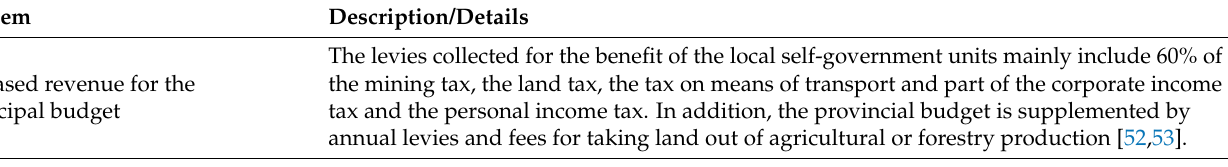
Table 5. Positive impacts in lignite life